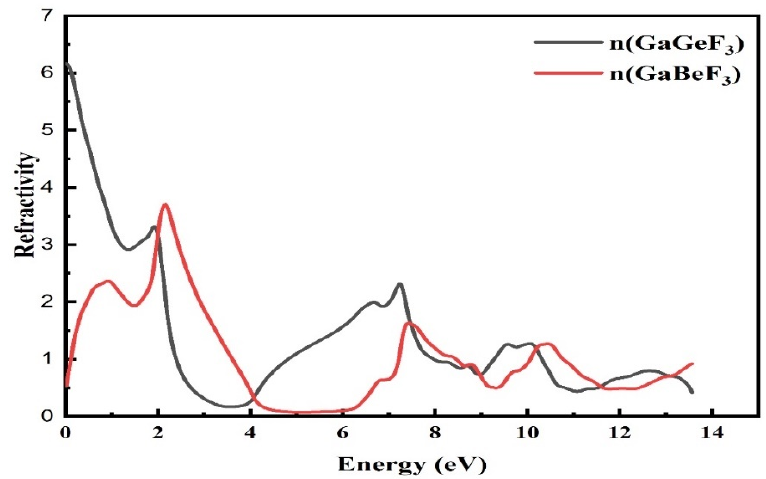
Figure 6. The calculated refractive index of the GaMF 3 compound (M = Ge and